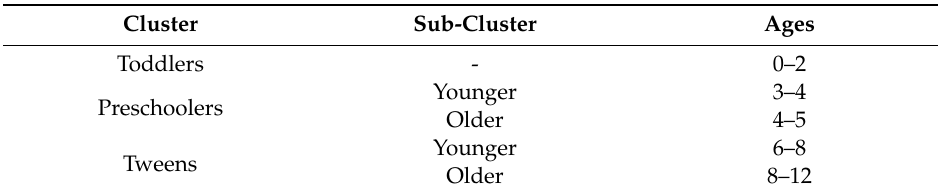
Table 1. Age clusters considered in the current